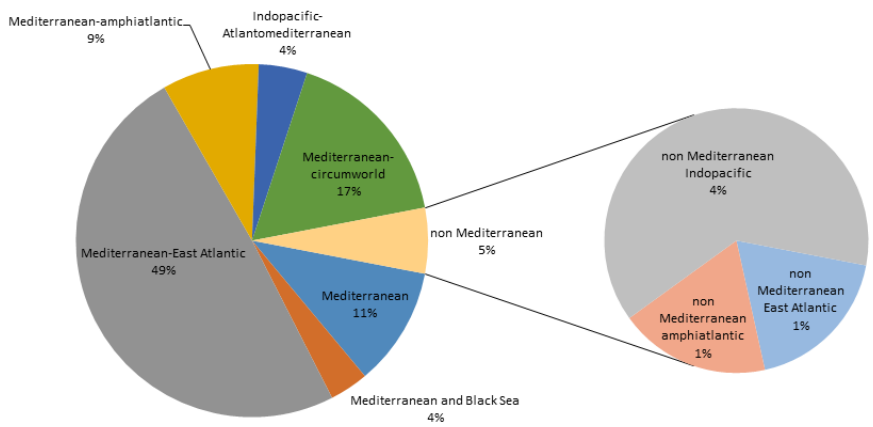
Figure 3. Zoogeographic origin of fish species recorded in the Adriatic Sea.